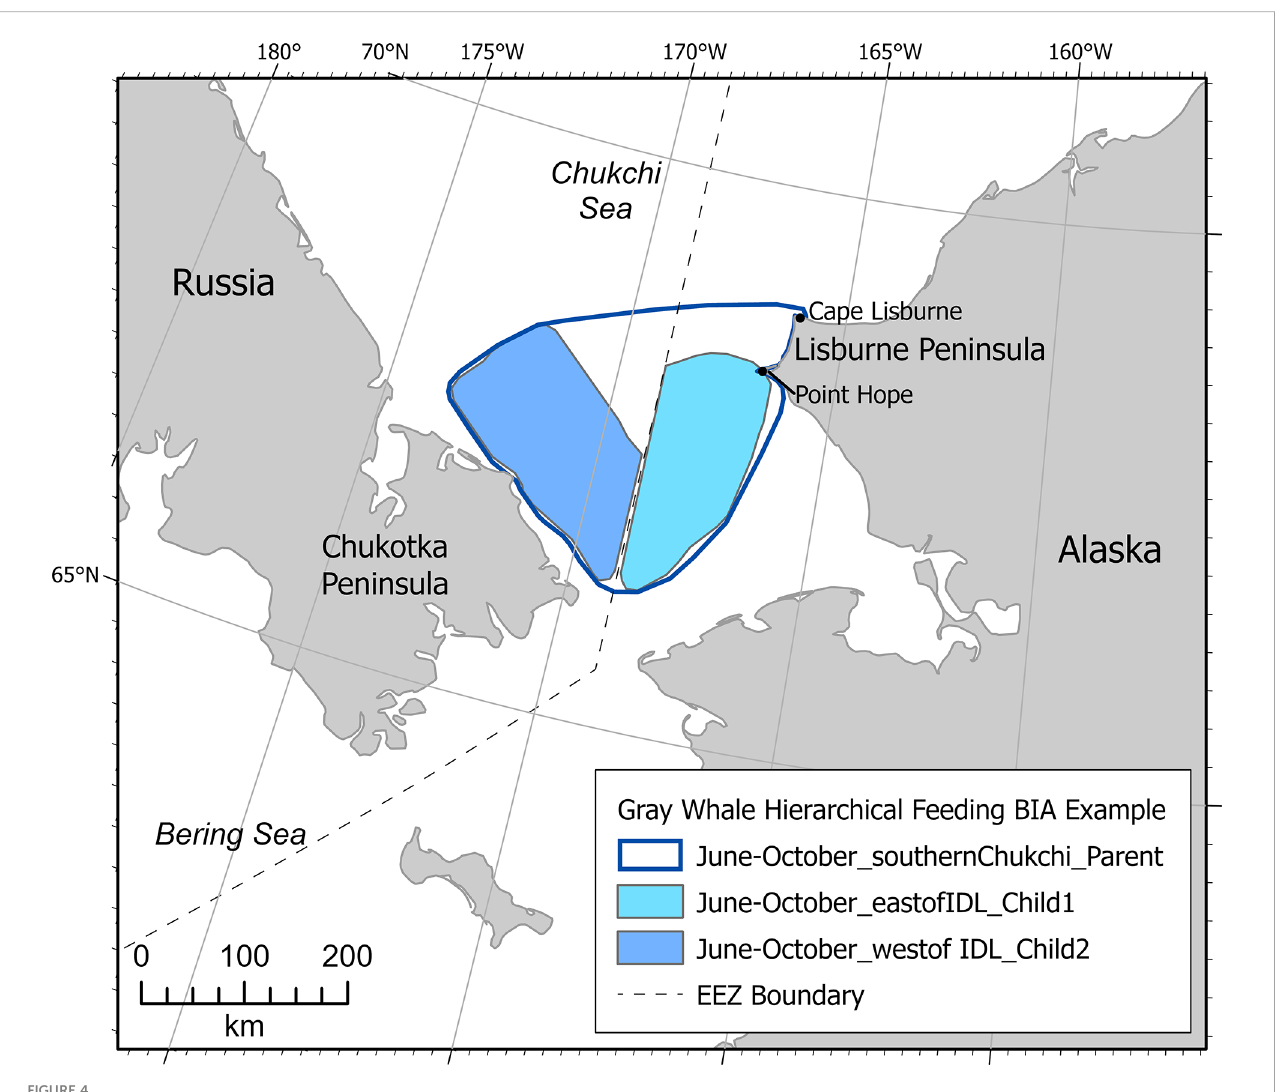
FIGURE 4 Example Arctic region BIA showing gray whale hierarchical-international (Gray Whale Hierarchical Feeding)